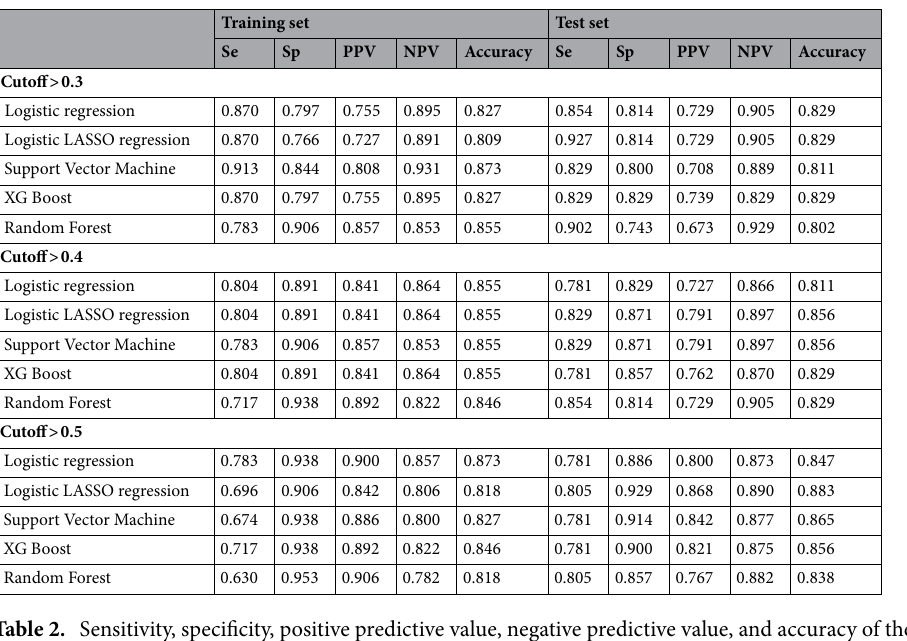
positive predictive value; Se, sensitivity; Sp, specificity.